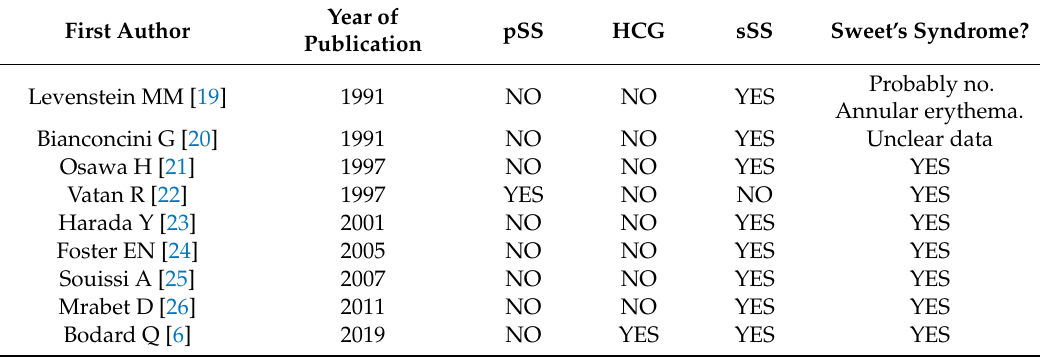
Table 2. Sweet’s syndrome, Sjogren’s syndrome, and hydroxychloroquine: Case reports in the indexed